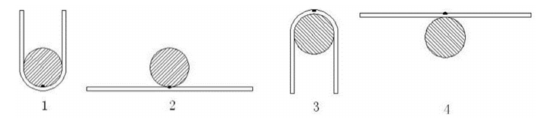
Figure 6. Schematic diagram of full cycle bending fatigue